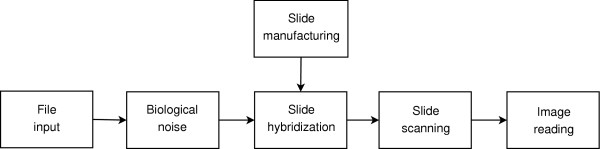
Microarray simulation model. Block diagram of the microarray simulation model.